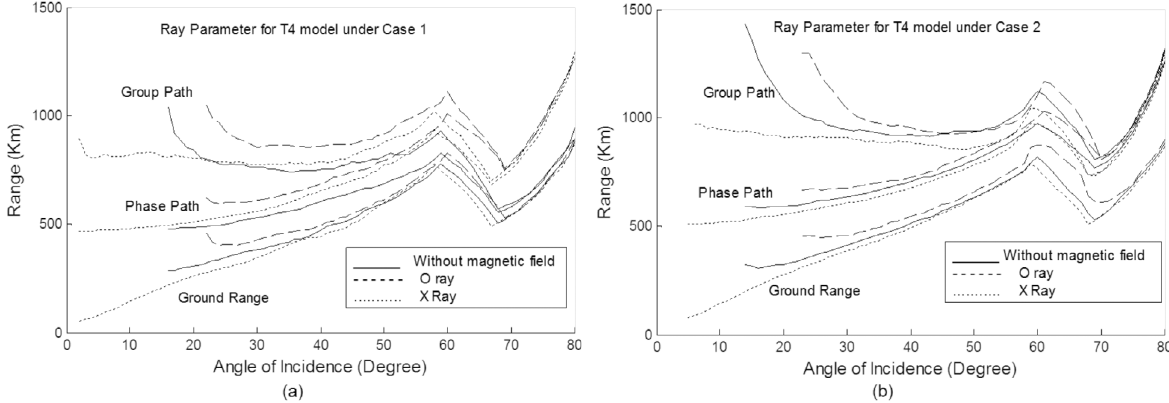
Figure 9. Ray tracing parameter variation for different angle of incidence at 7.5 MHz for T4 model of the ionosphere: (a) under Case 1 and (b) under Case